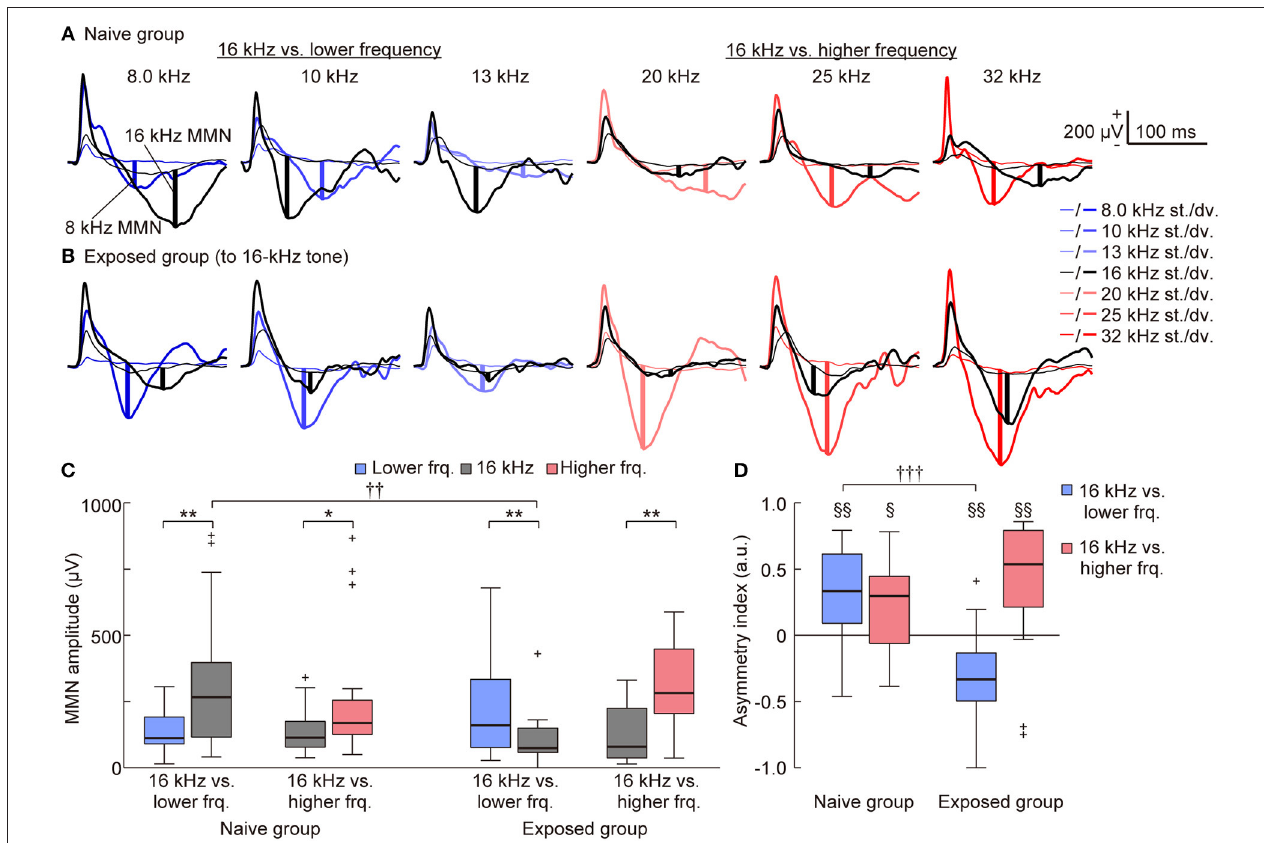
FIGURE 4 | Mere exposure decreased the mismatch negativity (MMN) response. (A–C) Representative traces of standard (thin lines) and deviant (bold lines) AEPs of each pair of frequency in (A) the naive and (B) the 16-kHz exposed group. Black lines indicate AEPs responding to 16kHz tone, blue and red lines indicate AEPs responding to the lower and higher tones paired with 16kHz, respectively. The vertical bold lines indicate the MMN amplitude in each trace. (C) When pooled in each condition, MMNs to incremental frequency changes were significantly larger than those to decremental changes in the naive group ( n = 7 per group × 3 tone pairs). After exposure, the MMN responses to incremental frequency changes were significantly smaller than were those to decremental changes when the paired frequency was lower than 16kHz (16kHz vs. lower frequency) but remained larger when the paired frequency was higher than 16kHz (16kHz vs. higher frequency). (D) The asymmetry index of MMN was therefore positive in both conditions in the naive group; however, it became negative in the exposed group when the paired frequency was lower than 16kHz ( n = 7 per group × 3 tone pairs). Statistical significance: * p < 0.05; ** p < 0.01 (Wilcoxon two-sided signed-rank test), †† p < 0.01; ††† p < 0.001 (Wilcoxon two-sided rank-sum test), § p < 0.05; §§ p < 0.01 (Wilcoxon two-sided signed-rank test vs. zero).